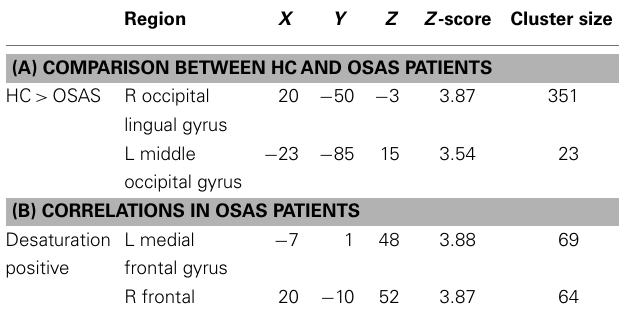
Table 3 |White matter volume (WMV) analysis results: (A) brain regions showing significant differences in GMV between healthy controls (HC) and obstructive sleep apnea syndrome (OSAS) patients; (B) brain regions showing significant correlation with nocturnal hypoxemia duration in OSAS patients (MNI coord.; 20 vox., uncorrected p <